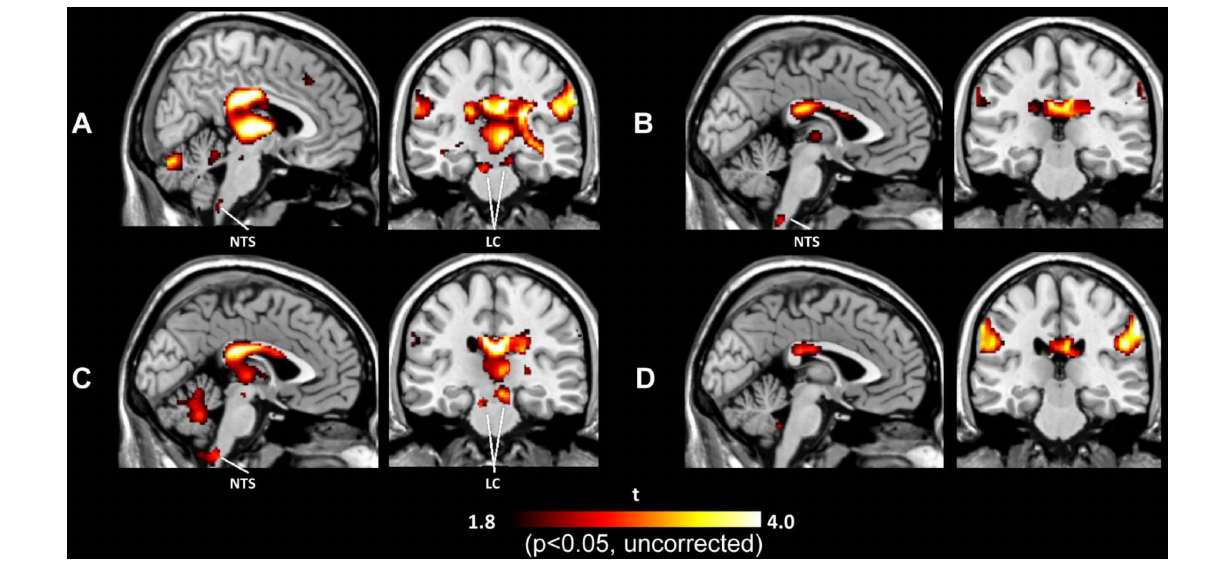
FIGURE 2 | Activation maps induced by tVNS in the tragus (A) , inferoposterior wall of the external acoustic meatus (B) , concha (C) , and earlobe (D) . tVNS at the tragus and concha activated the locus coeruleus (LC) and nucleus of the solitary tract (NTS), while tVNS at the ear canal and earlobe did not activate either brain